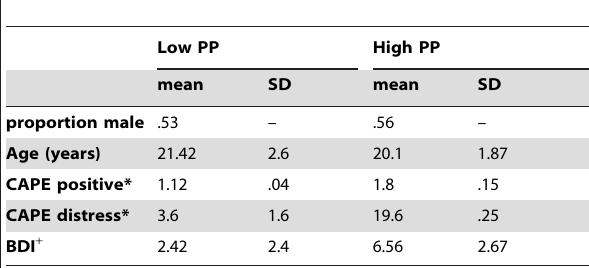
Table 1. Demographic information, BDI and CAPE scores for both